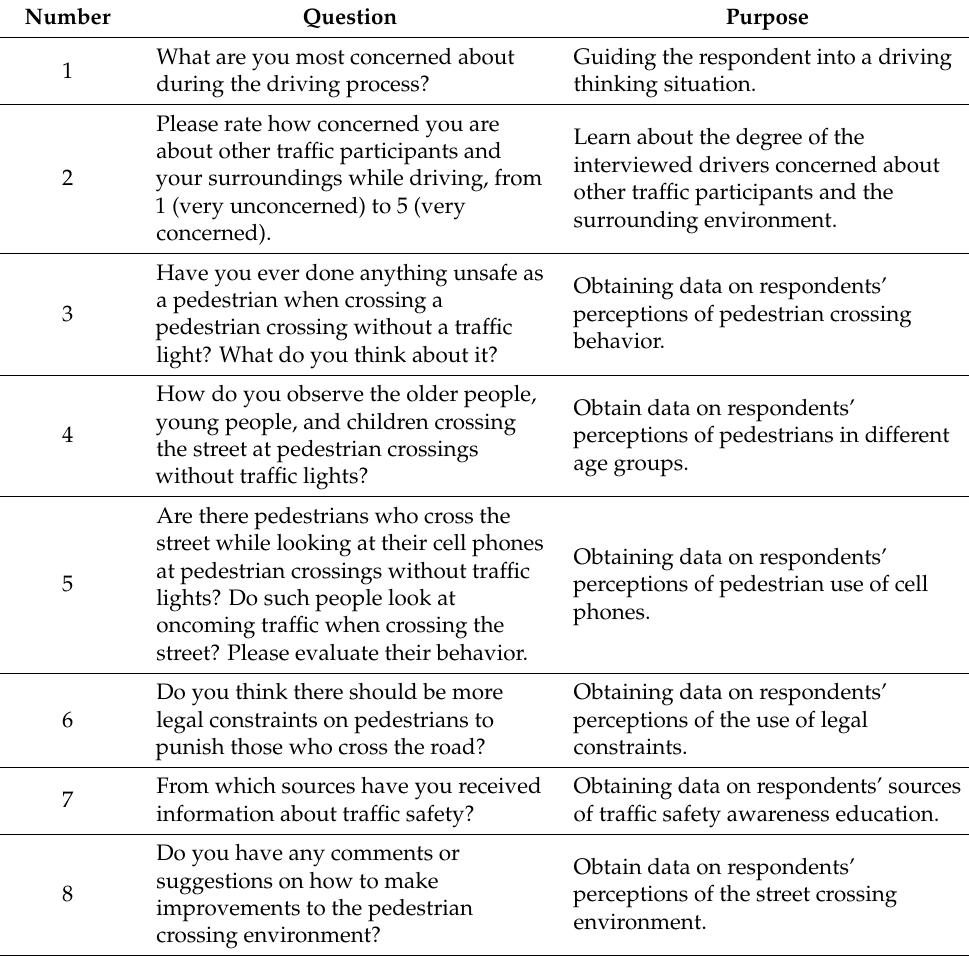
Table 2. Semi-structured interview